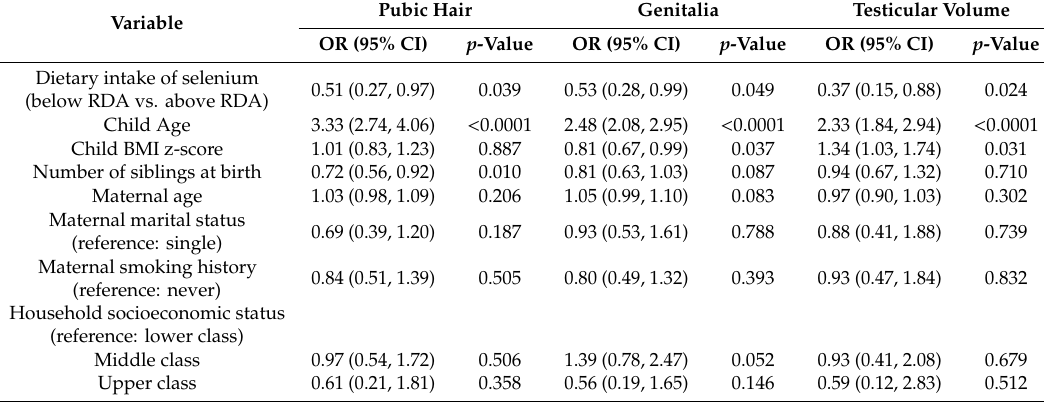
Table 4. Adjusted associations between dietary intake of selenium (below RDA vs. above RDA) and physician-assessed secondary sex characteristics in boys at age 10–18 years a